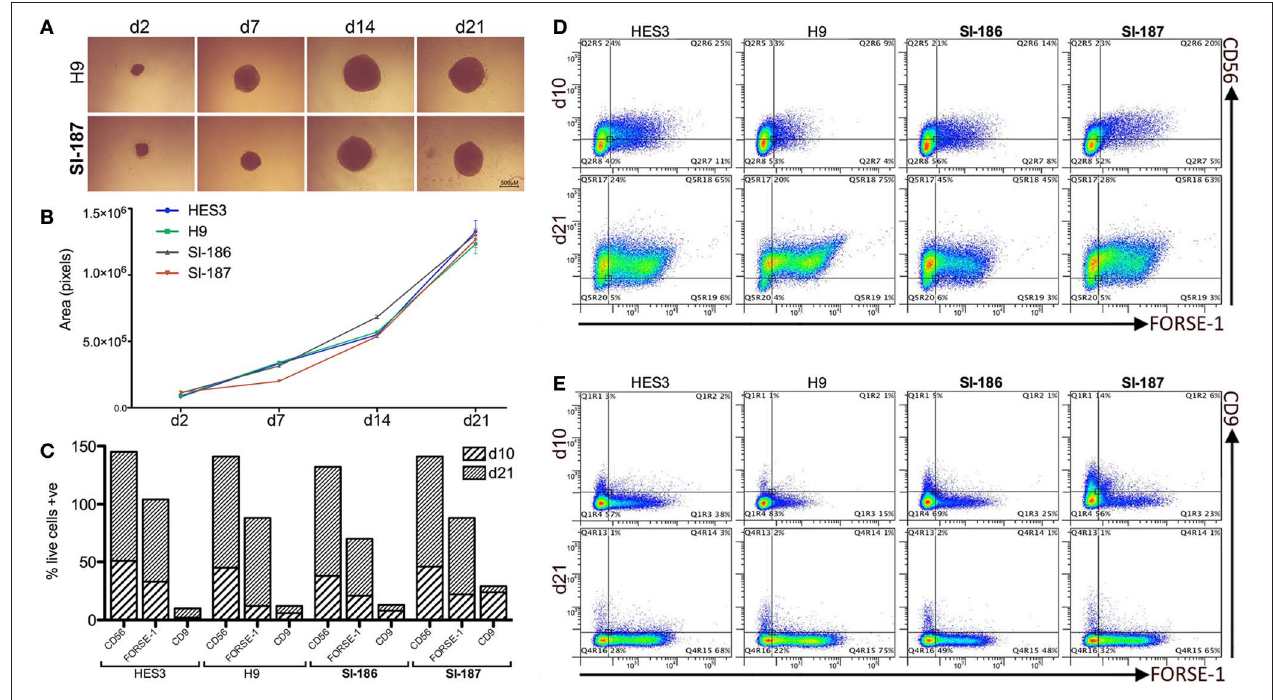
FIGURE 2 | Neural progenitorlineage specificationandexpansion is consistentbetween HDandcontrolneurospheres.(A) Brightfield time course representations throughout neurosphere differentiation stages (B) . Neurosphere growth rate analysis across all HD and control lines (One-Way